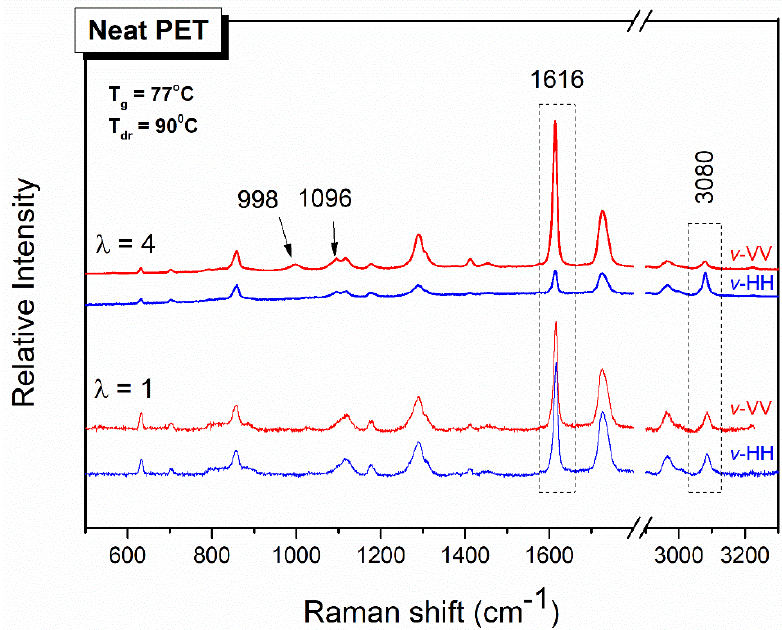
Figure 4. Polarized Raman spectra of PET film undrawn, λ = 1, and drawn to λ = 4 in two different polarization geometries, VV and HH, with respect to the position of the specimen relative to the laboratory-fixed coordinates, v . The spectra are shifted along the intensity axis for clarity. H: Horizontal, V: Vertical.